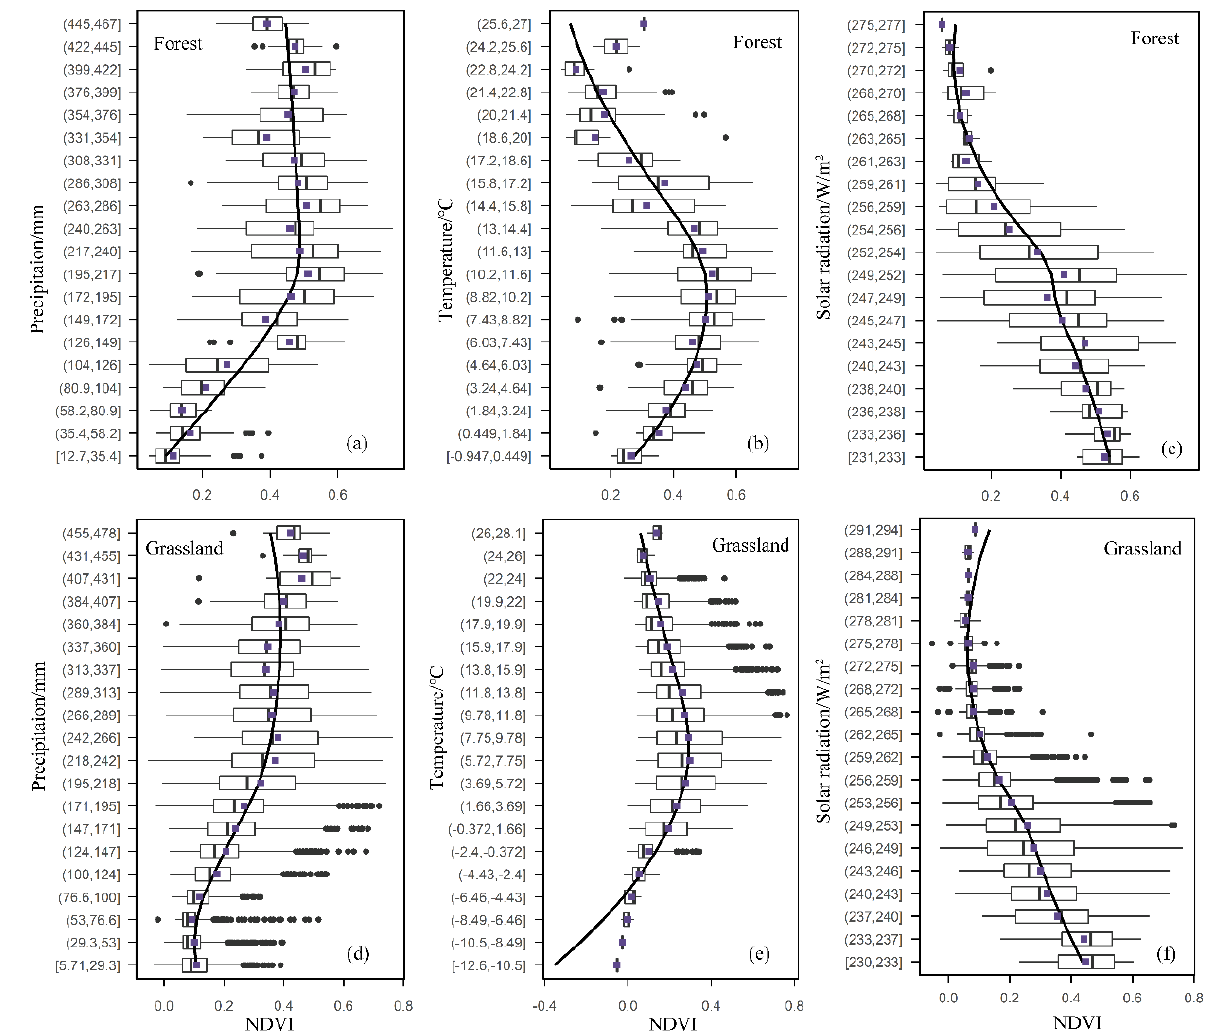
Figure 4. Changes in Normalized Difference Vegetation Index (NDVI) with changes in precipitation, temperature, and solar radiation for forest (( a − c ), respectively) and grassland (( d − f ), respectively) in the arid region of northwestern China.